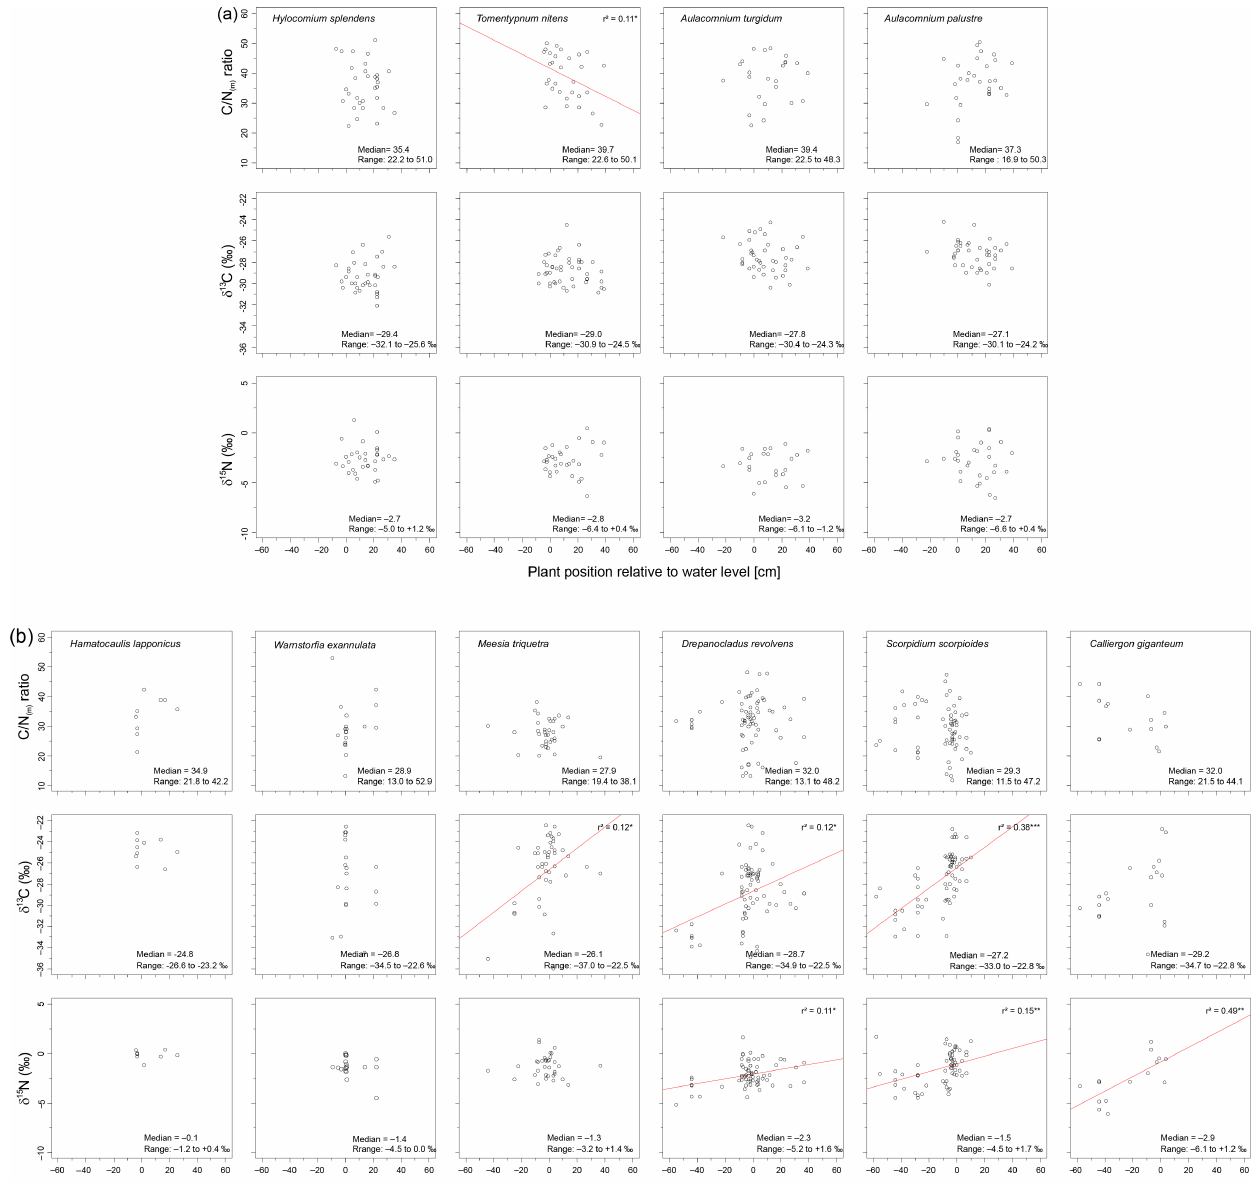
Figure 3. (a) Intraspecific relationships of the C / N ratio and the stable isotope values of carbon and nitrogen related to the water level of the xero-mesophilic moss group. Regression lines (red) are only plotted for significant datasets. (b) Intraspecific relationships of the C / N ratio and the stable isotope values of carbon and nitrogen related to the water level of the meso-hygrophilic moss group. Regression lines (red) are only plotted for significant